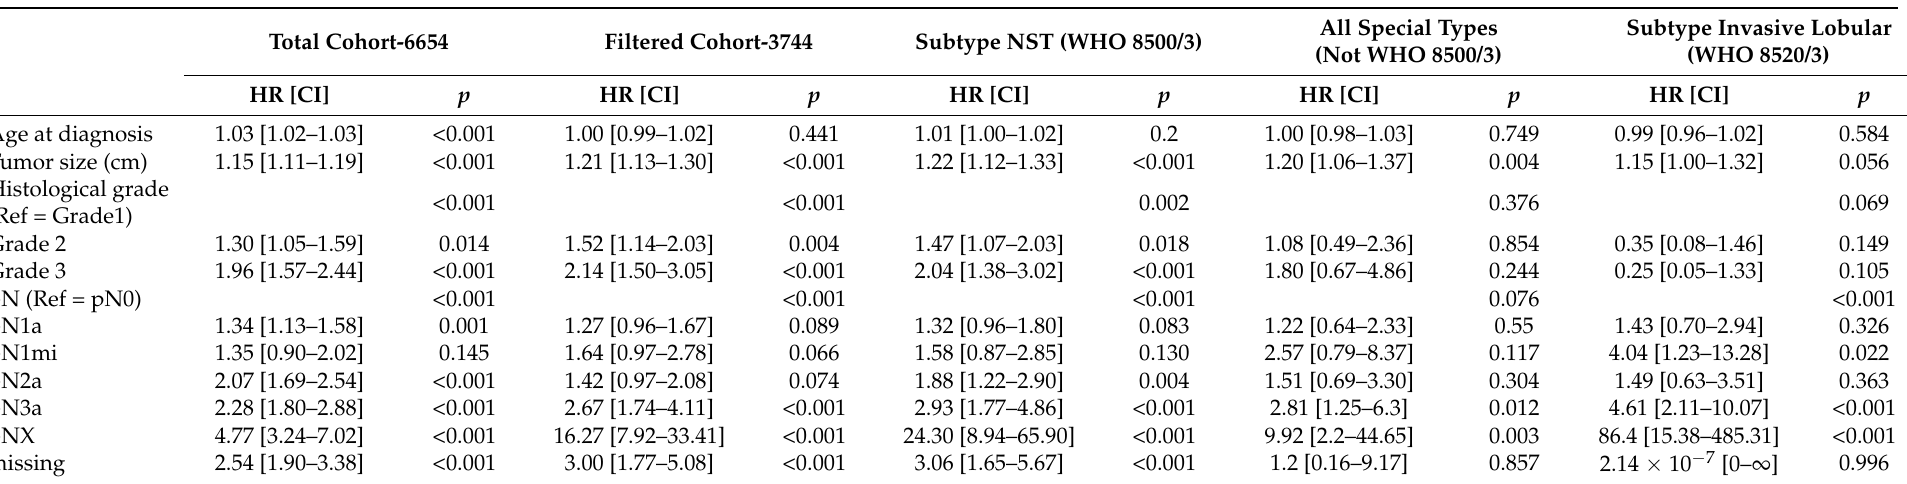
Table 3. Results of the multivariate Cox regression models in the different subsets. Hazard Ratios (HR) with 95% confidence intervals (CI) and p -values ( p ) are given for each of the 5 different patient